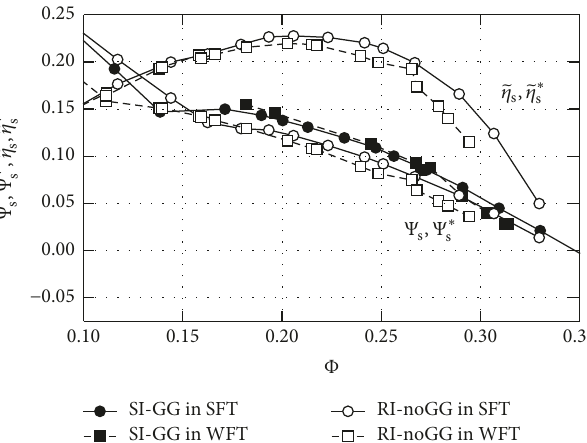
Figure 7: Comparison of static fan pressure and efficiency measured in standard fan test rig and wind tunnel fan test rig of Fan A in FD.